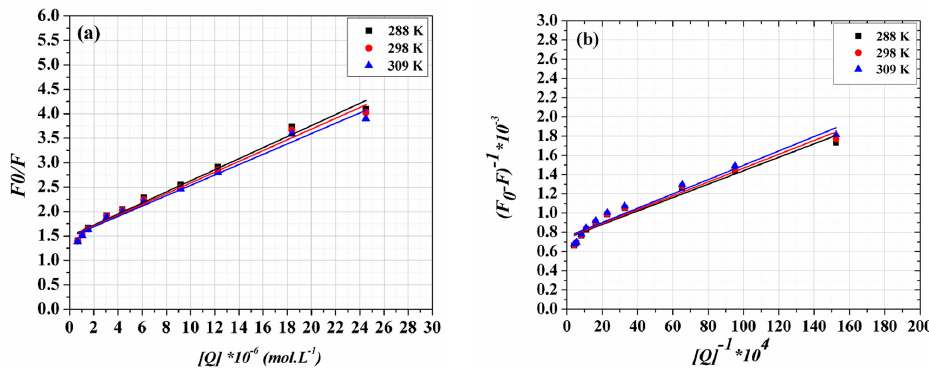
Figure 4. Stern–Volmer ( a ) and Lineweaver–Burk ( b ) plots at various temperatures. Table 1. Parameters computed from both Stern–Volmer and Lineweaver–Burk relations for compound 3- BSA binding.